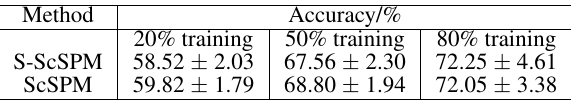
Table 2. Overall classification accuracy on Changping data set Overall classification accuracy on UCM data set and Changping data set is shown in Table 1 and Table 2, respectively. On UCM data set, S-ScSPM averagely outperforms ScSPM by 1% , and the standard deviations are also smaller. On Changping data set, S-ScSPM achieves 1% lower classification rate than Sc- SPM under the setting of 20% and 50% training data, while slightly outperforms ScSPM when using 80% data for training.